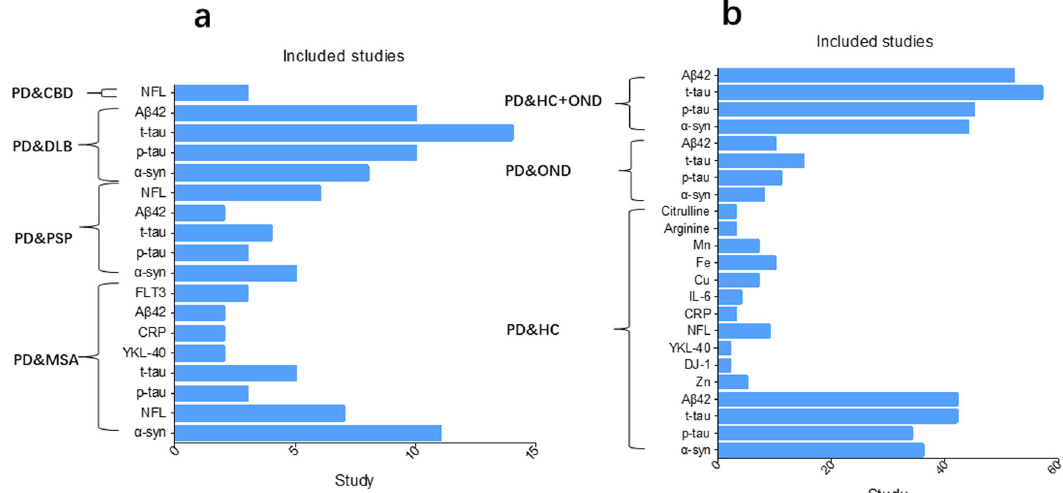
Fig. 2 The number of studies in the meta-analysis for PD versus the parkinsonism and control groups. a The number of included studies for the PD versus parkinsonism groups. The number of studies included for the indicated biomarkers comparing PD patients to those with MSA, PSP, DLB, or CBD is illustrated. b The number of included studies for the PD versus control groups. The number of studies included for the indicated biomarkers comparing PD patients to the control group or the combined HC and OND groups is illustrated. PD Parkinson ’ s disease, PSP progressive supranuclear palsy, MSA multiple system atrophy, DLB dementia with Lewy bodies, CBD cortico-basal degeneration, HC healthy control, OND other neurodegenerative diseases, A β 42 the 42-amino-acid form of A β , p-tau phosphorylated tau, t-tau total tau, NFL neuro fi lament light-chain protein, α - syn α -synuclein, IL-6 interleukin-6, CRP C-reactive protein, CHI3L1 YKL-40, chitinase-3-like protein 1, Cu copper, Mn manganese, Fe iron, Zn